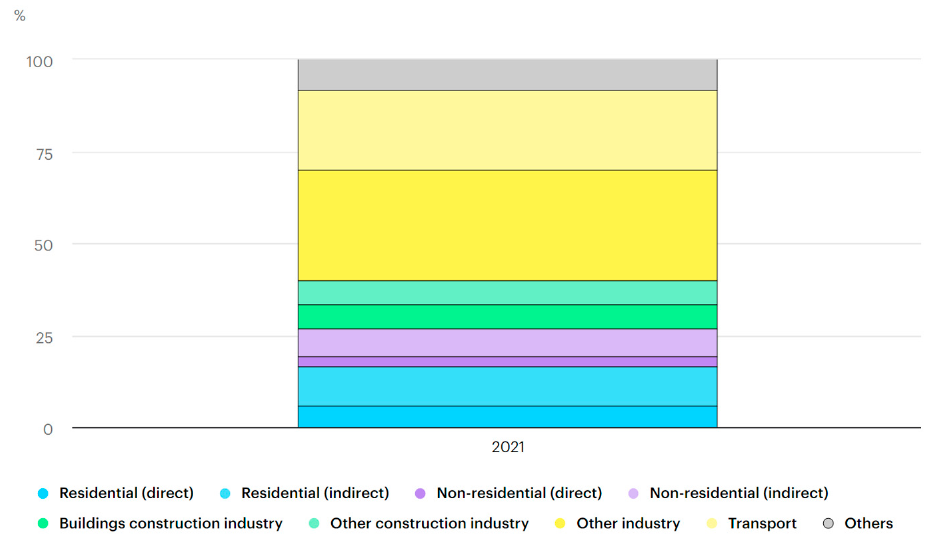
Figure 1. Global energy and process emissions from buildings, including embodied emissions from new construction, 2021 [1].